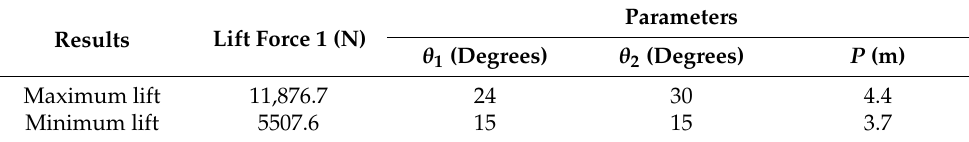
Table 5. Maximum and minimum values of the parameters for case III. Figure 11. Convergence of lift force values (Objective Function) for case III.